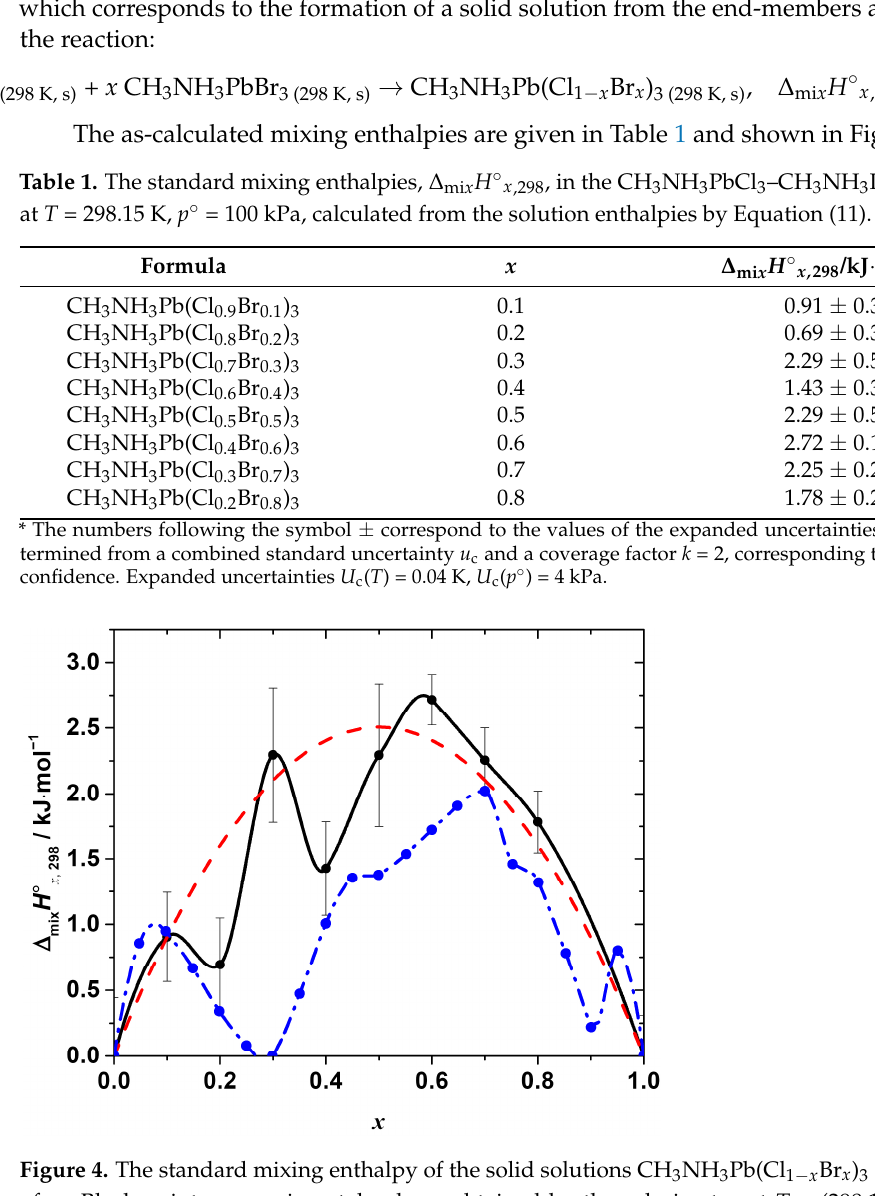
Figure 4. The standard mixing enthalpy of the solid solutions CH 3 NH 3 Pb(Cl 1 − x Br x ) 3 as a function of x . Black points—experimental values, obtained by the calorimetry at T = (298.15 ± 0.04) K, p ° = (100 ± 4) kPa (expanded uncertainties, level of confidence 95%) in this work, black line—Akima spline interpolation of these points. Red dashed line represents the best fit of the regular solution model. Blue points—values, obtained in the molecular dynamics simulation experiment, described in [19] (reproduced from the graph in the original paper), blue dashed line—Akima spline interpolation of the data.